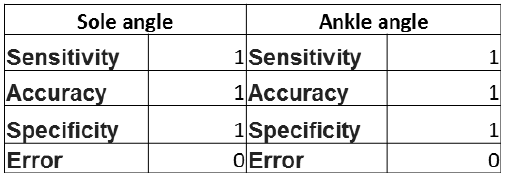
Table 4. Statistical data of confusion matrix for the bending